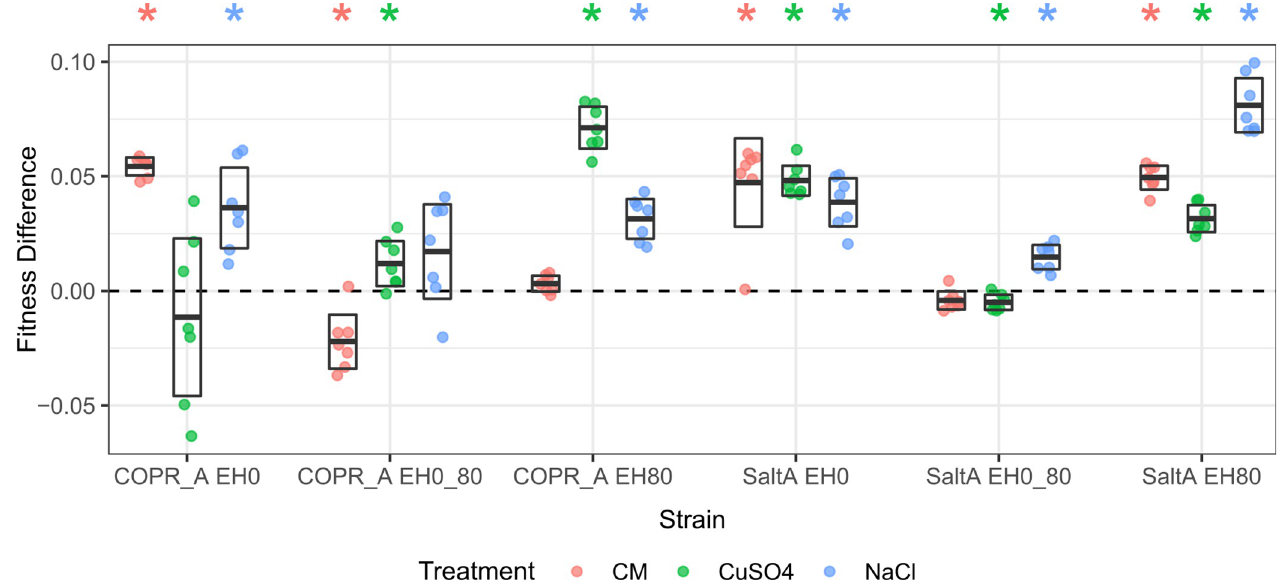
Fig 2. Competitive fitness differences between evolved strains and their ancestors in three environments. Strains labels are based on evolution under constant stress (EH80), fluctuating stress (EH0_80), or no stress (EH0) for both copper (COPR) and sodium (SaltA) treatments. Fitness was measured over a three day period in the presence of 5 μ M copper (CuSO4), 103 mM sodium (NaCl) or without stress (CM). Boxes represent the 95% confidence interval bisected by the mean of 7 replicates. Stars indicate FDR <